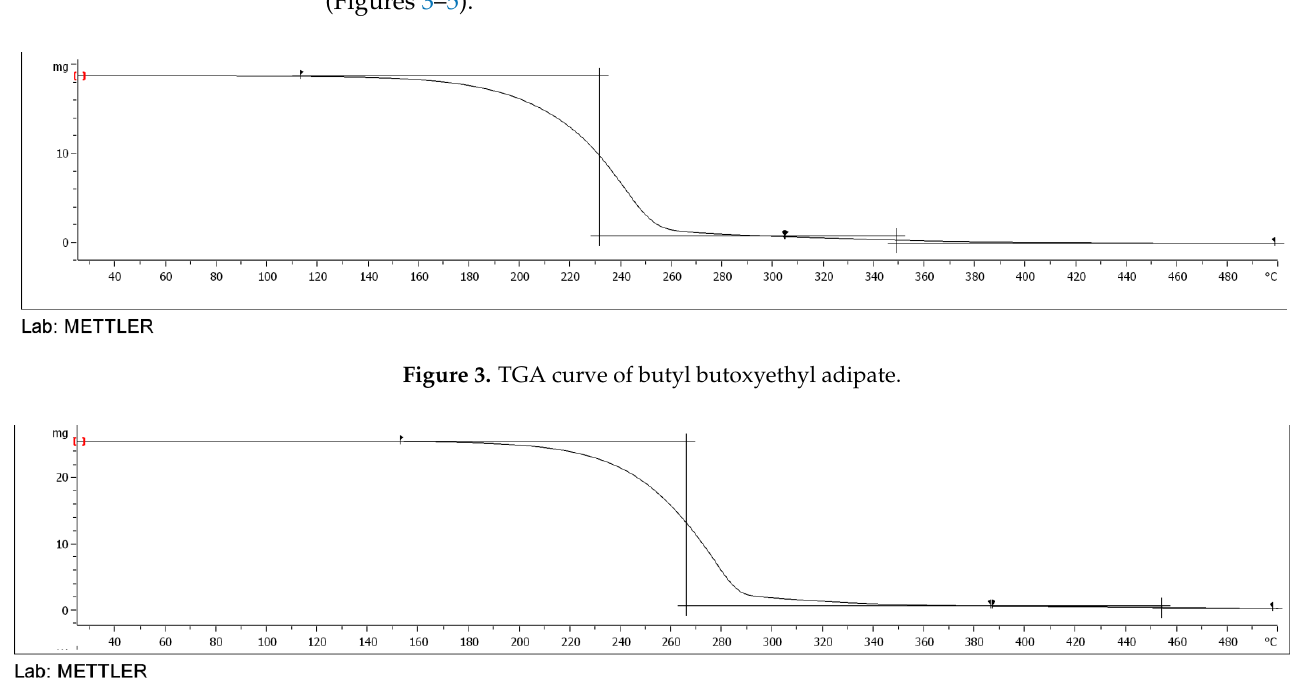
Figure 5. TGA curve of DOP. On the DSC thermograms obtained during thermal analysis, the decomposition of butyl butoxyethyl adipinate ( I ), decyl butoxyethyl adipinate ( II ), as well as the decomposition of DOP, corresponds to the characteristic exothermic effect observed at temperatures above 210 °C and caused by the occurrence of thermooxidative degradation of the product. DSC curves of the synthesized compounds show that during the processing of these additives in the composition of PVC compositions, weight loss due to volatility is excluded, which ensures the stability of the composition of the PVC composition during processing and, thereby, improves the manufacturability of compounds based on new plasticizers (Figures 6–8).